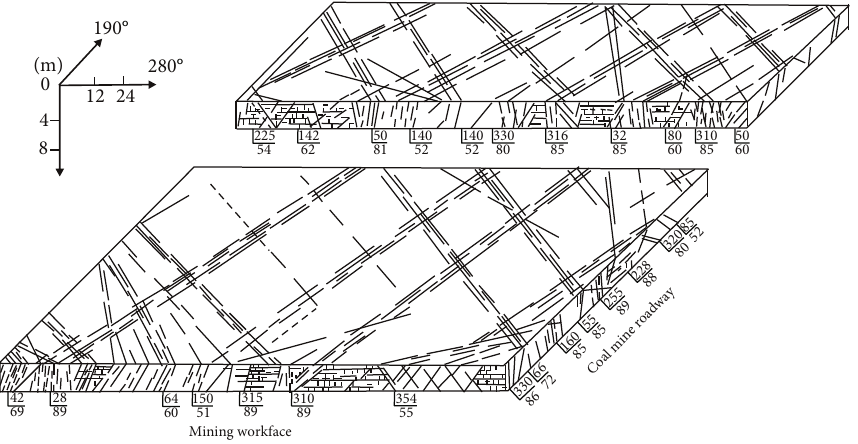
Figure 2: Exogenetic fractures in coal seams in the southern Qinshui Basin (revised from